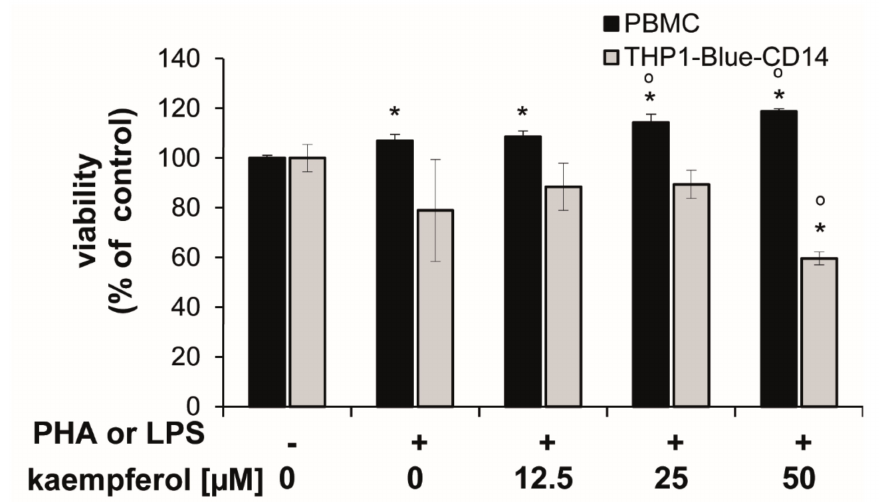
Figure 3. Human peripheral blood mononuclear cells (PBMC) and THP1-Blue CD14 cells stimulated with or without 10 µ g / mL phytohemagglutinin (PHA) (for PBMC) or 100 ng / mL lipopolysaccharide (LPS) (THP1-Blue-CD14) prior to incubation with kaempferol for 24 h. Resazurin conversion was determined as a measure for viability. E ff ect is shown in relation to the activity in the unstimulated controls (set to 100%). Shown are mean values ± S.E.M. of three independent experiments, each performed at minimum in triplicates (* p < 0.05 compared to unstimulated control; ◦ p < 0.05 compared to stimulated